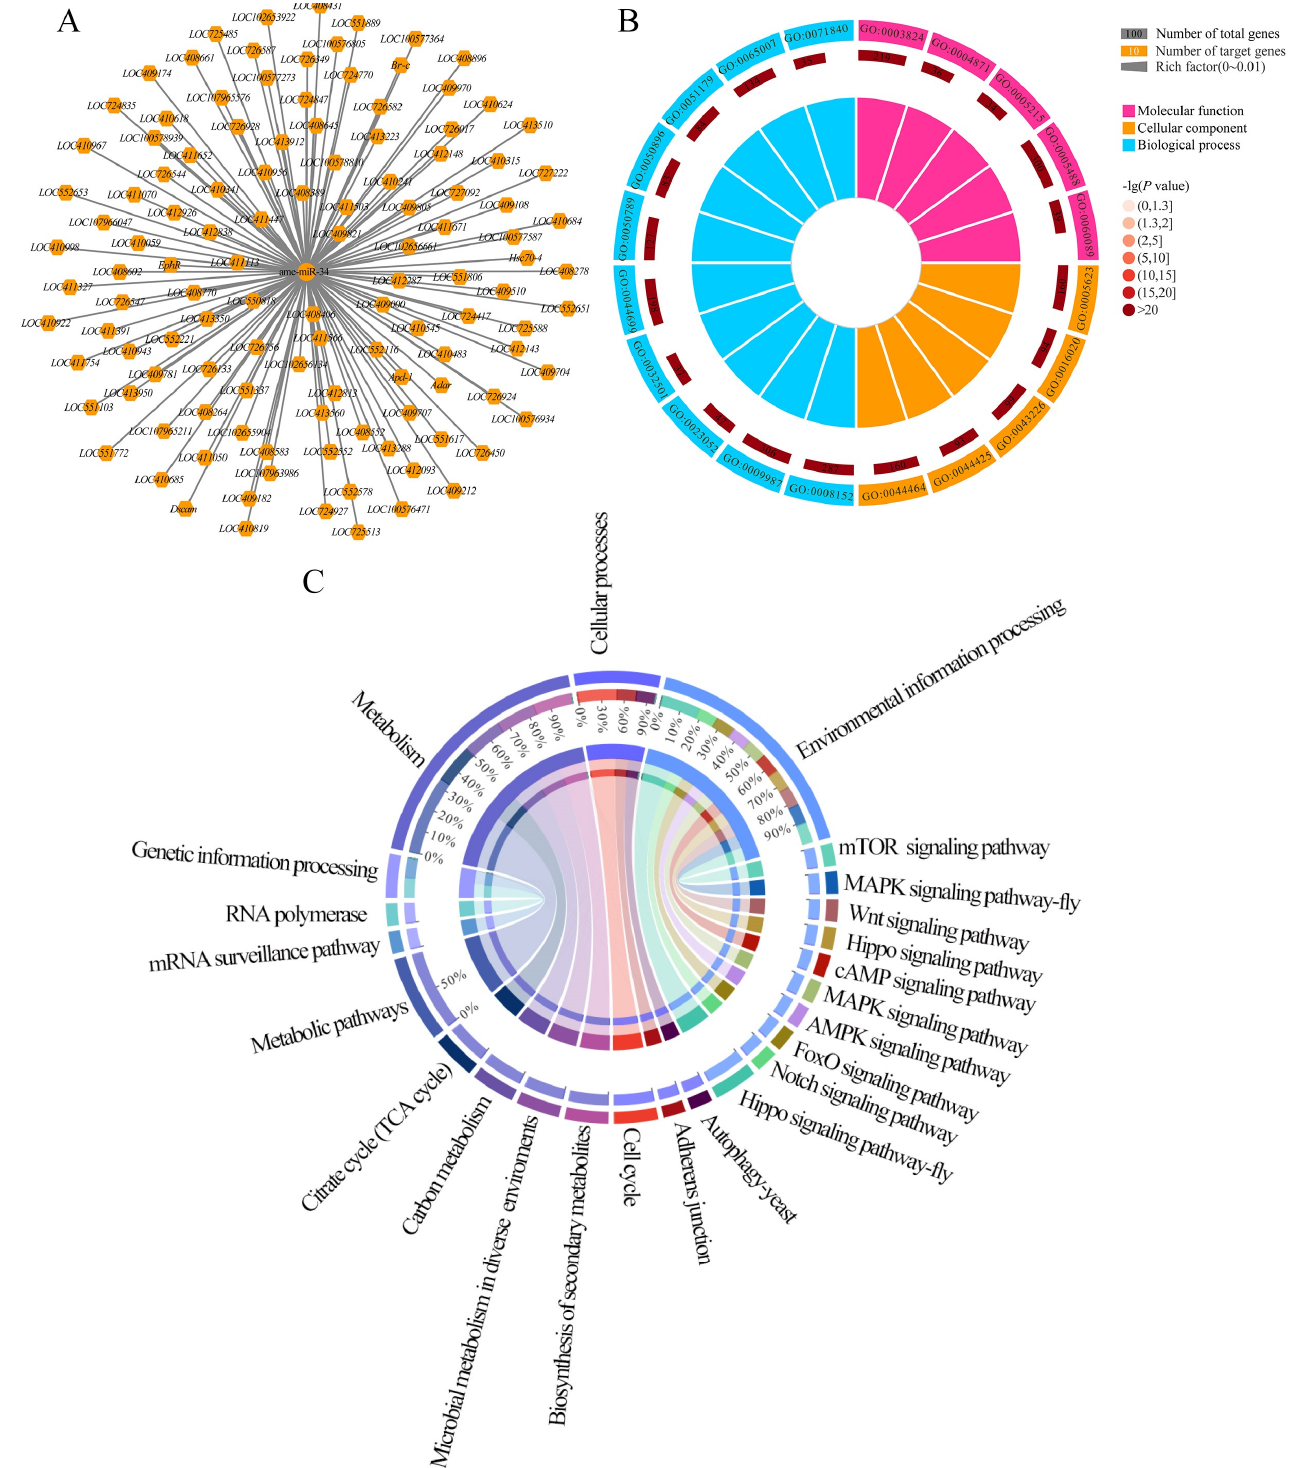
Figure 6. Regulatory network and database annotation of ame-miR-34-targeted genes. ( A ) Regulatory network between ame-miR-34 and target genes; ( B ) GO database annotation of targets; ( C ) KEGG database annotation of targets.